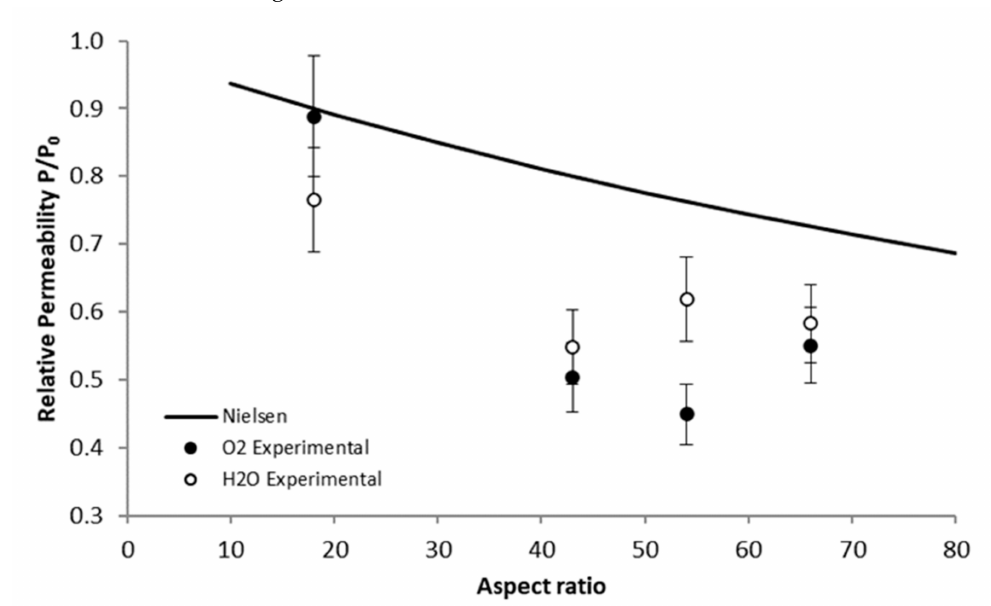
Figure 8. Comparison of the relative permeability of the studied nanocomposites with the Nielsen predictive law ( T = 25 ◦ C, a w = 1, filler rate = 2